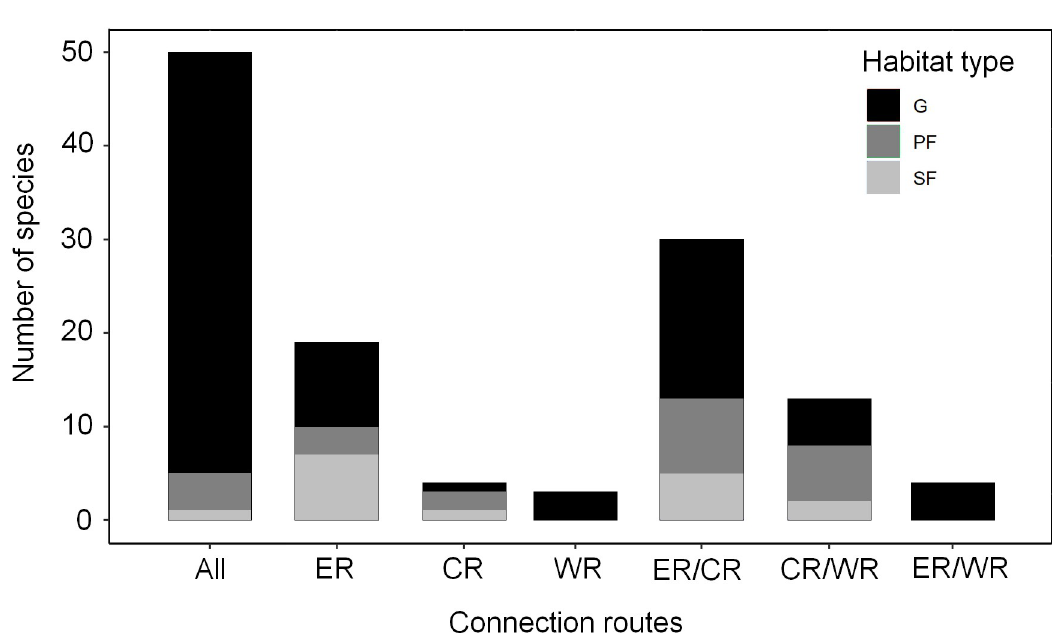
Fig 3. Number of mammalian species assumed to have dispersed by each of the connective routes between Amazonia and the Atlantic Forest. The routes are presented along the x-axis: Eastern route (ER), Central route (CR), and Western route (WR), and combinations of routes (ER + CR, ER + WR, CR + WR, and “All” for ER + CR + WR). The grayscale represents species habitat preferences where SF = Strict forest specialists, PF = Species that prefer forest habitat, and G =